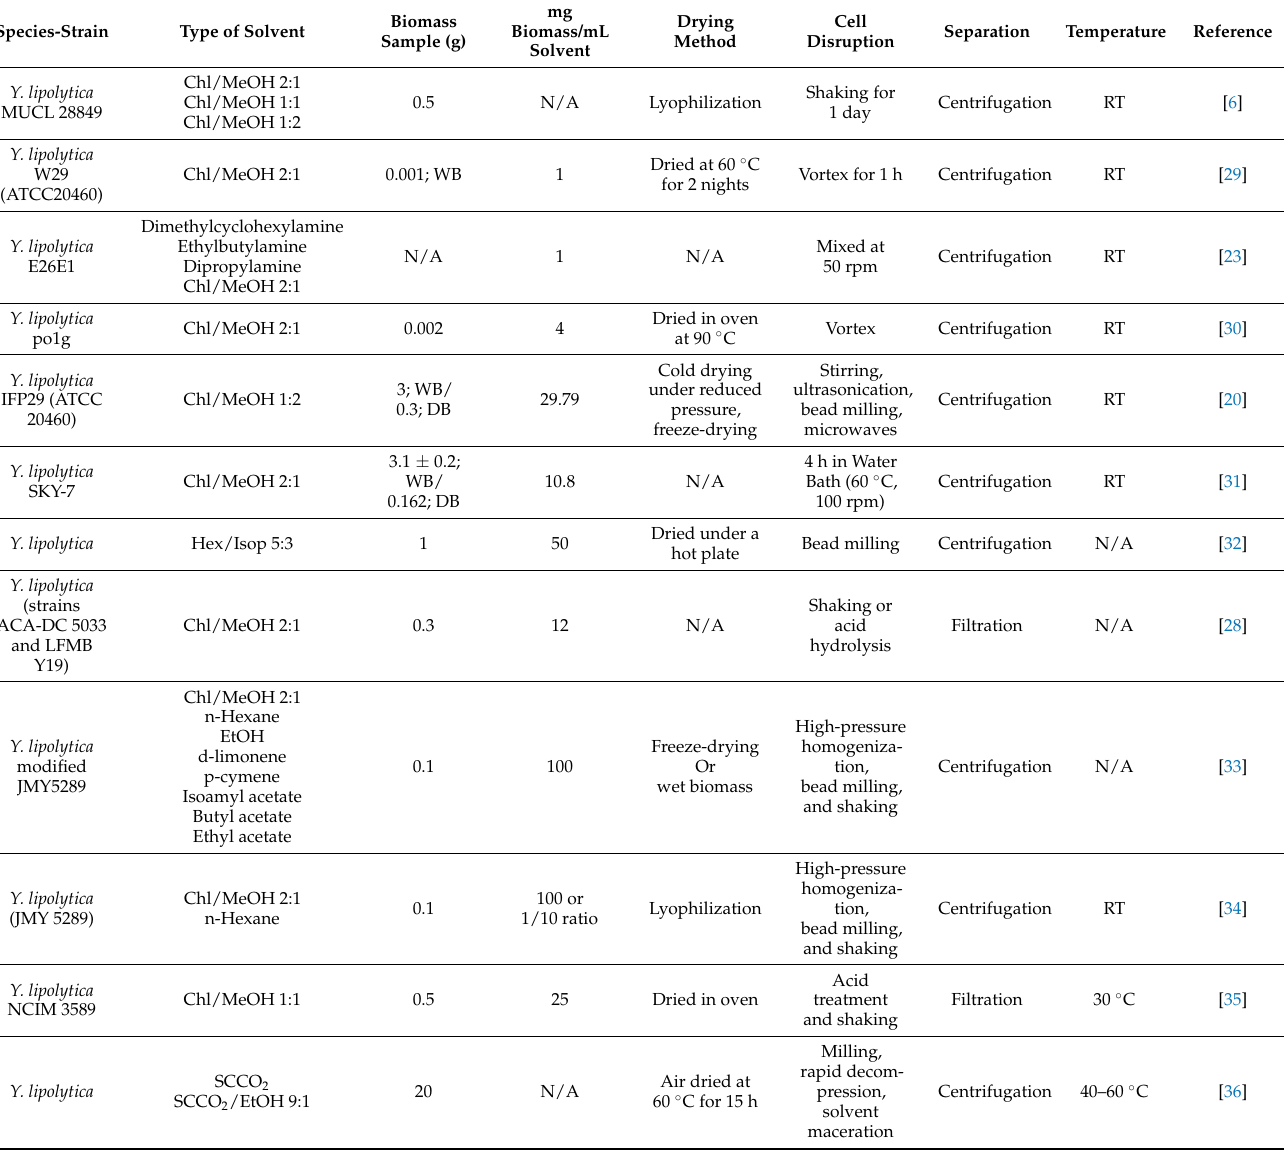
Table 1. Summary of studies of lipid extraction from Yarrowia lipolytica ( Y. lipolytica ) yeast, conducted mainly using chloroform/methanol mixture as solvent. Critical extraction steps and parameters are briefly